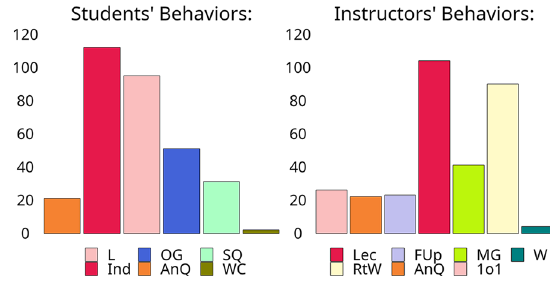
Fig. 4 Histograms of the COPUS behaviors over the Init period